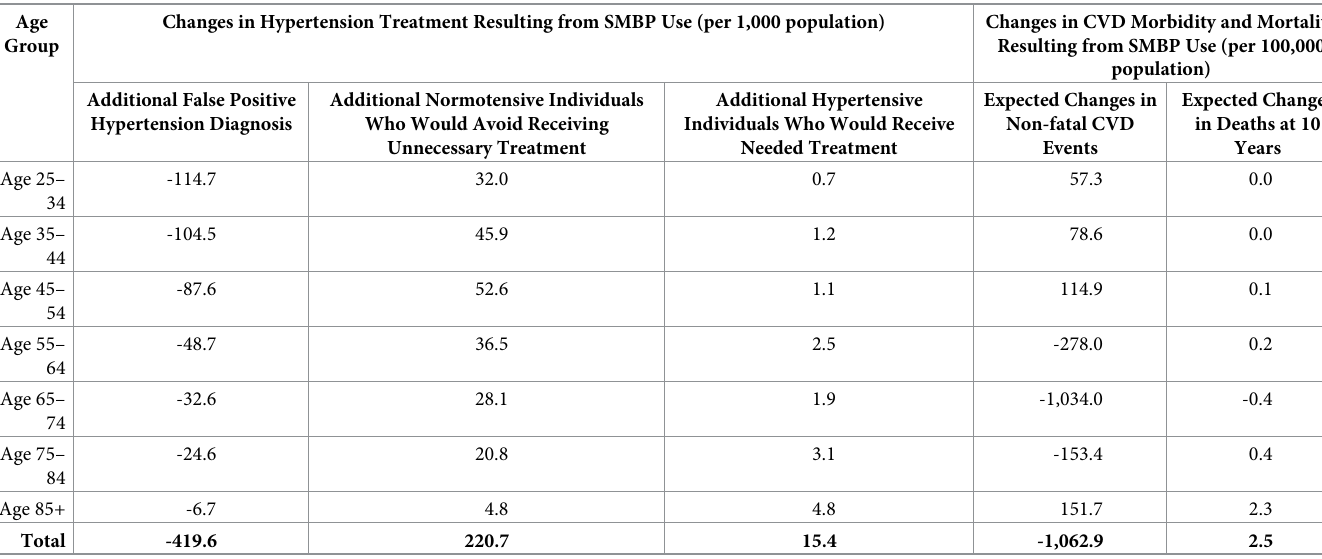
Table 3. Health impact of SMBP (changes in treatment, morbidity, and mortality). Changes in Hypertension Treatment Resulting from SMBP Use (per 1,000